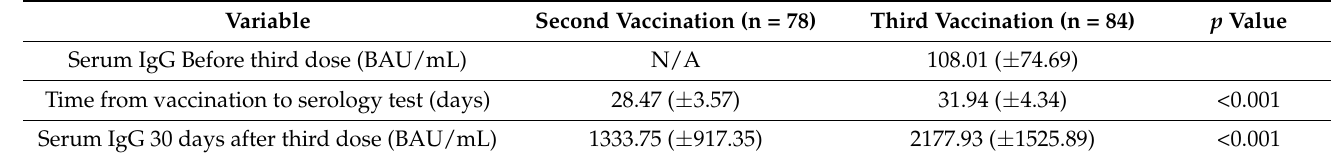
Table 3. Blood serology for SARS-CoV-2-specific antibodies in in 78 pregnant women who received a second dose and 84 pregnant women who received a third (booster) dose of BNT162b2 vaccine.